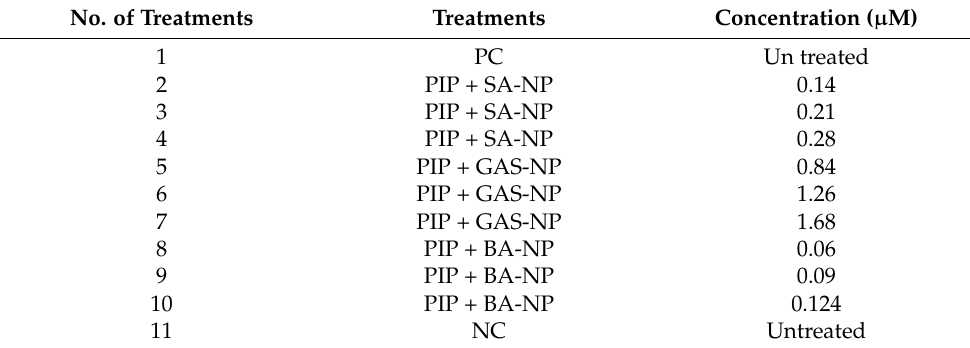
Table 1. Definition of treatments relative to applying SA-NP, GAS-NP, and BA-NP treatments on phytoplasma